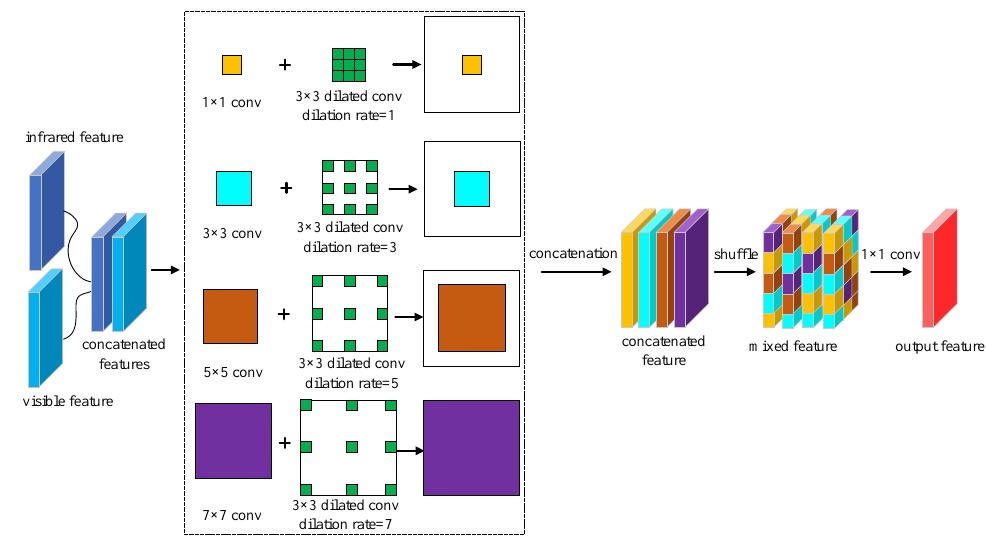
Figure 5. The fusion shuffle module structure where the shuffle is performed after